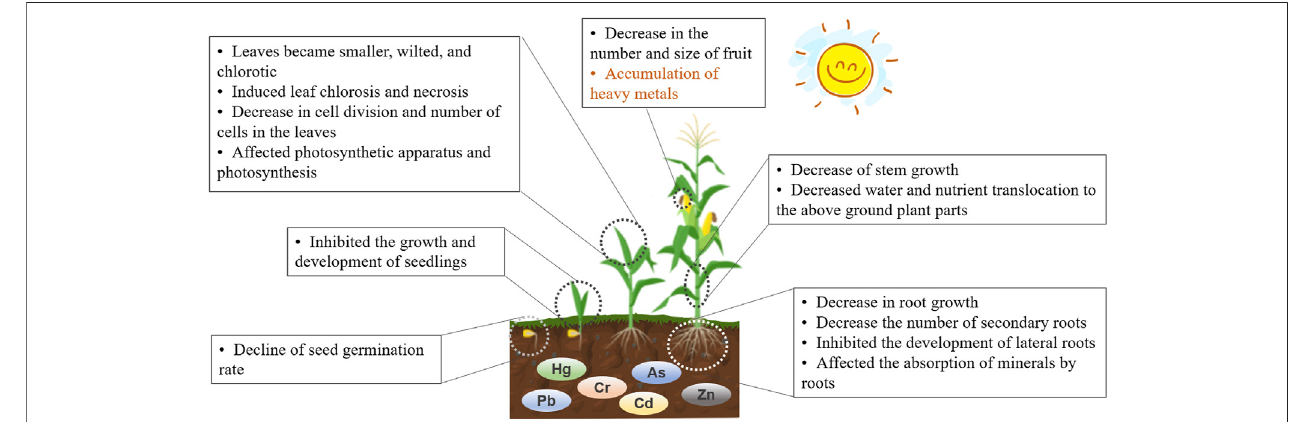
FIGURE 3 | The morphological and physiological changes in plants induced by